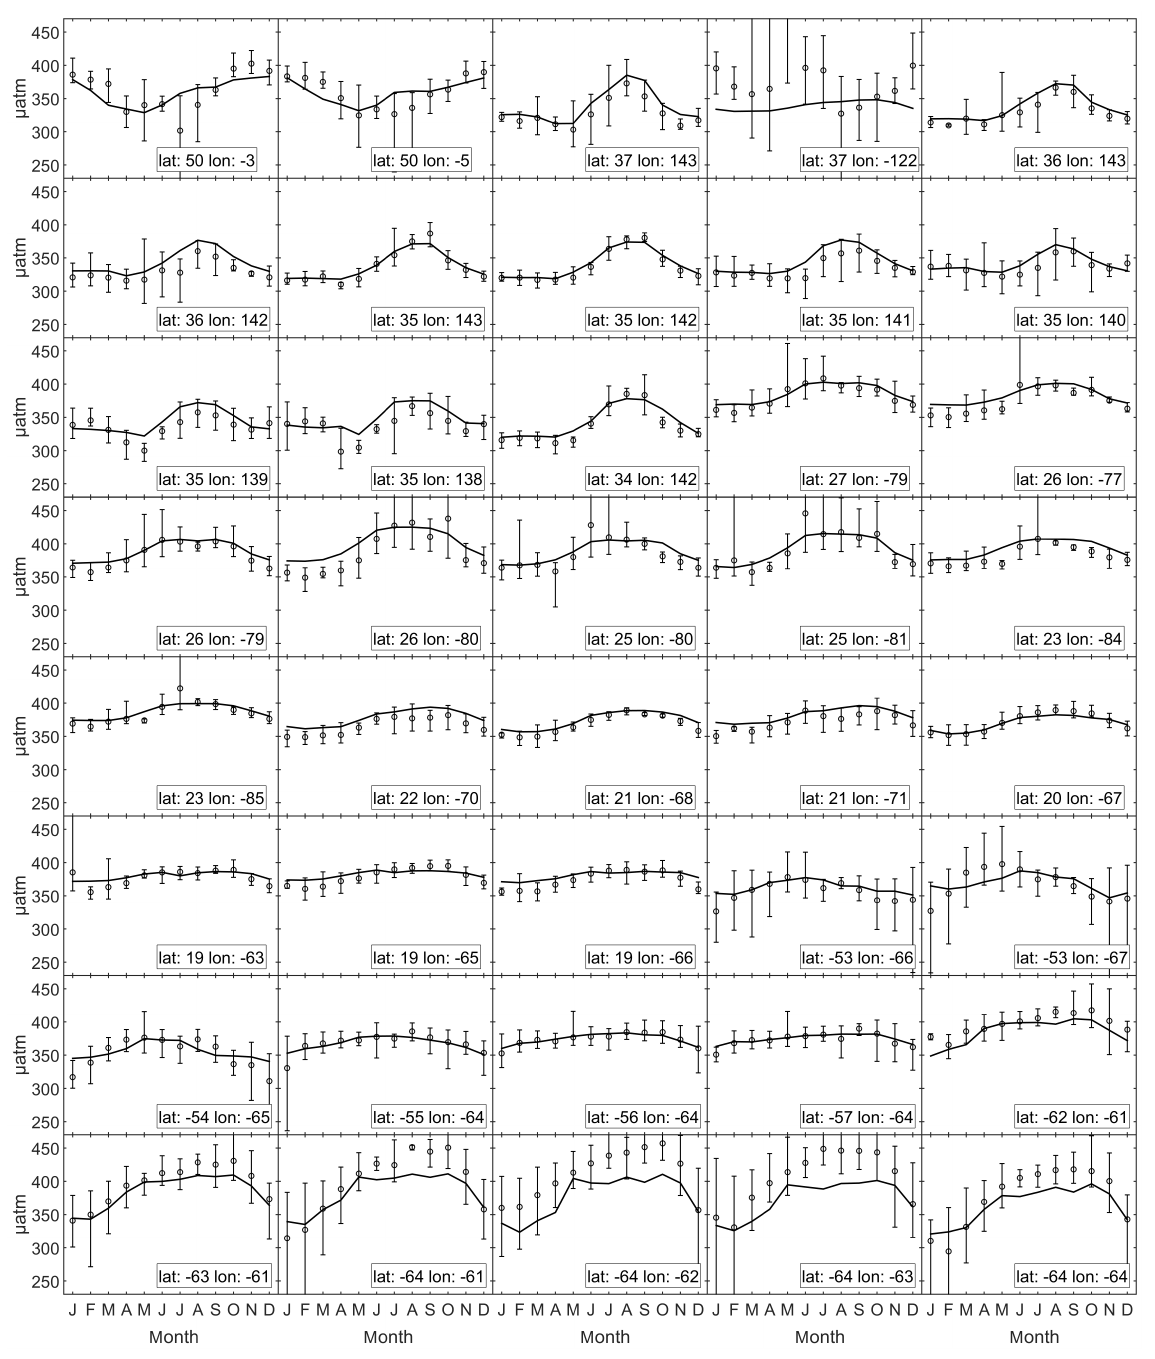
Figure 7. Climatological monthly mean p CO 2 extracted from the LDEO ∗ database (points) and generated by the artificial neural network (lines) for grid cells with more than 40 months of data. The error bars associated with the data represent the interannual variability, reported as the highest and lowest recorded values for a given month at a given